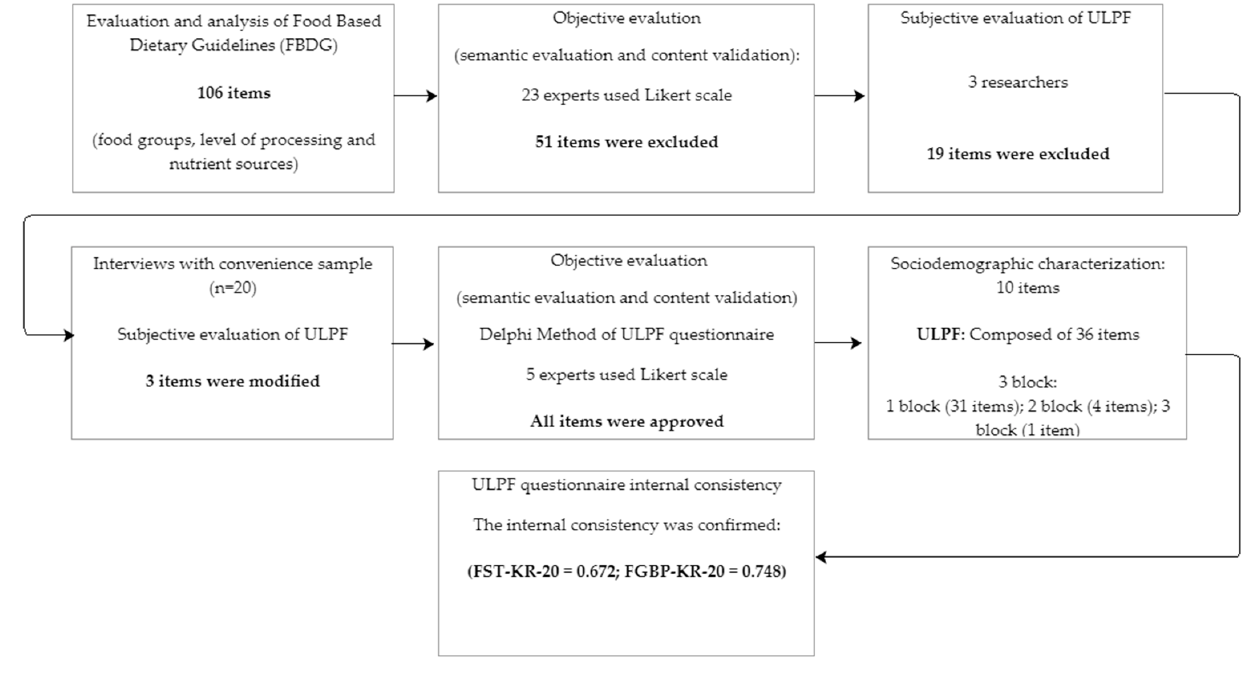
Figure 1. Stages of the construction, content validation, and semantic evaluation of “Understanding of the Level of Processing of Food” (ULPF).